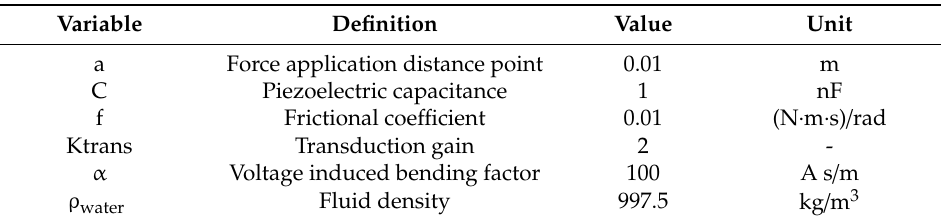
Table 2. Model parameters.